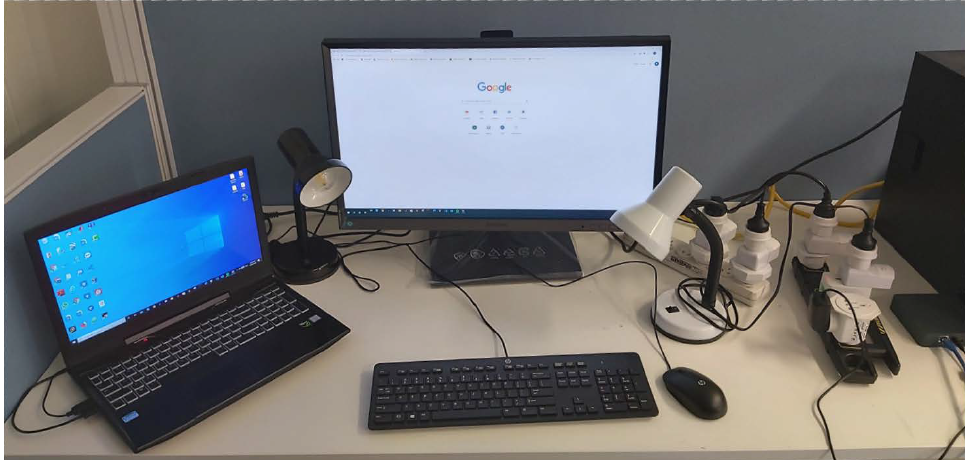
Figure 5. The lab testing setup where four plugs and a gateway (on the right) are connected to a laptop, a screen, and two desk lamps. Their energy usage data was collected and remote control was established over those